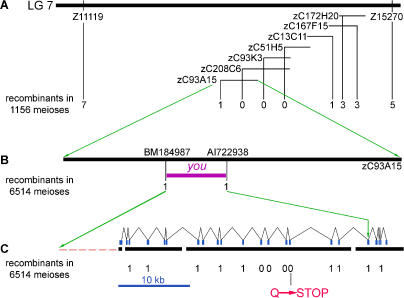
Positional Cloning of the you Locus(A) Genetic and physical map of the you region on LG 7, showing the initial flanking SSLPs and the BACs used in the chromosome walk. The number of recombinants in 1,156 meioses is shown for the SSLP markers and for mapped BAC end sequences.(B) Diagram of BAC zC93A15, with expressed sequence tag markers BM184987 and AI722938 shown flanking the you locus. Both BM184987 and AI722938 showed one recombinant out of 6,514 meioses, and were genetically localized on opposite sides of you.(C) The genomic region of the you locus is depicted by horizontal black bars. Gaps in these bars represent fragments of genomic sequence that were not obtained in the sequencing analysis. Exons are depicted by blue rectangles, and the number of recombinants in 6,514 meioses is shown below each mapped exon. Single nucleotide polymorphisms in four exons always segregated with the you locus, and one of these exons harbored a single nucleotide lesion predicted to change a glutamine codon to a stop codon and truncate the open reading frame.